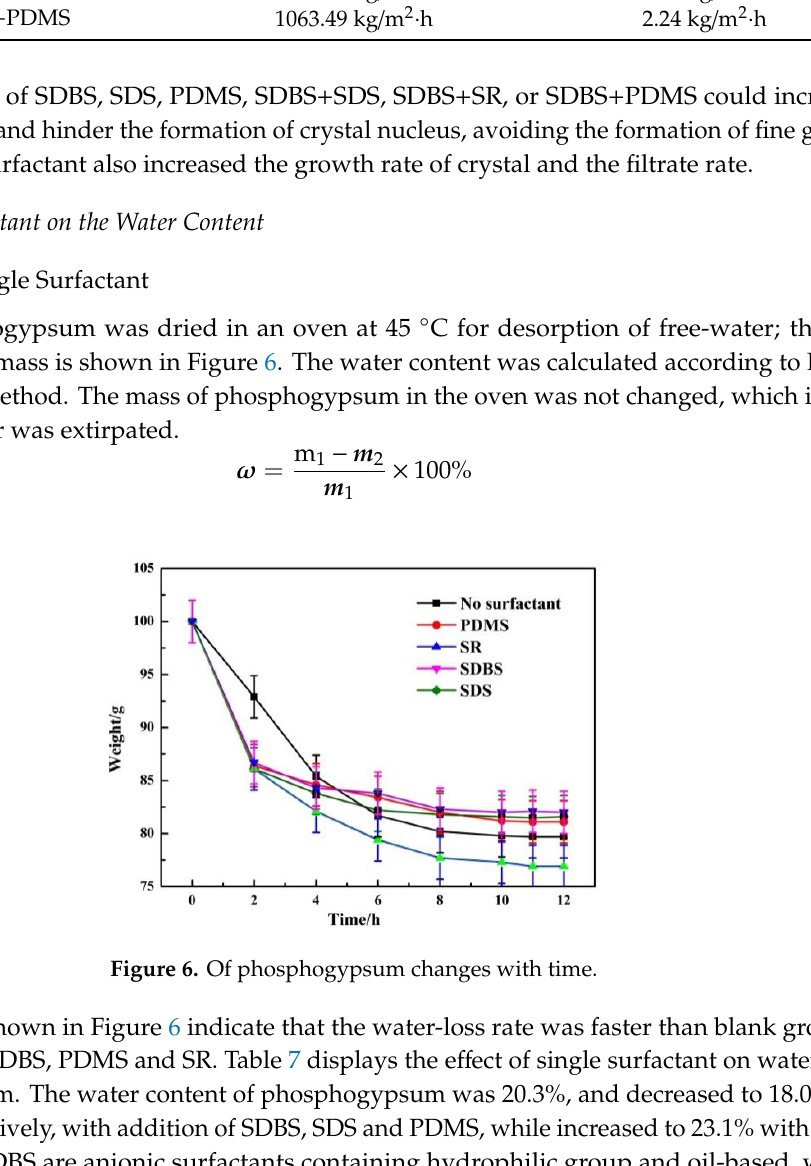
Table 6. of the species of surfactants on the filtration rate of phosphogypsum.